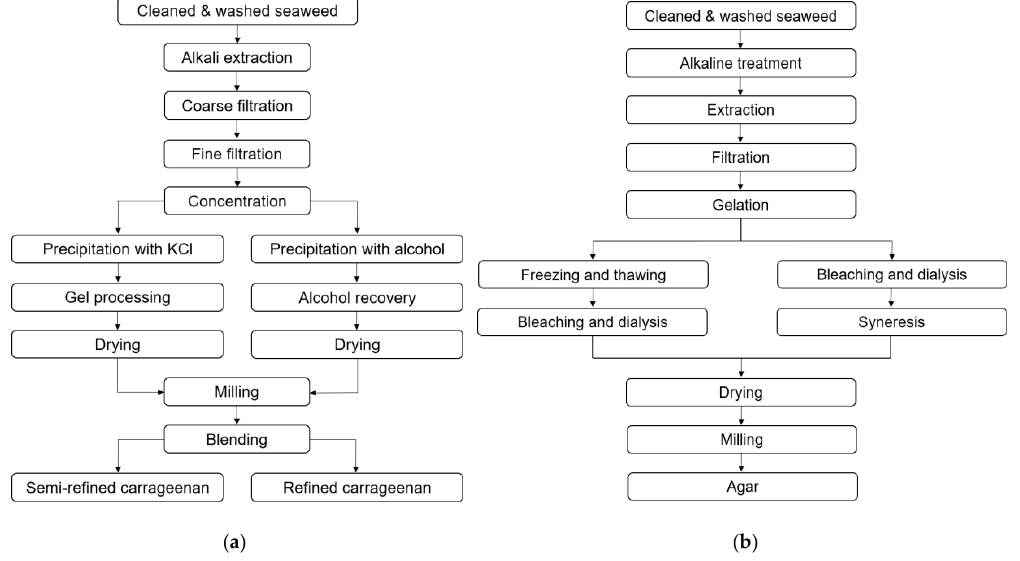
Figure 2. Conventional extraction method of refined carrageenan (RC) and semi-refined carrageenan (SRC) ( a ). Alkaline method for agar extraction [95] ( b